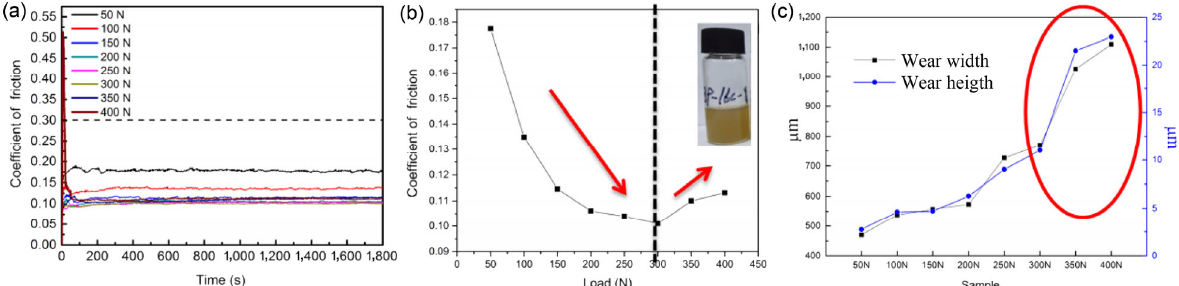
Fig. 15 Friction properties of BP-16C at various loads, (a) COF of BP-16C at various loads; (b) the change trend of steady friction coefficient; (c) wear width and wear height of lower samples (disc).